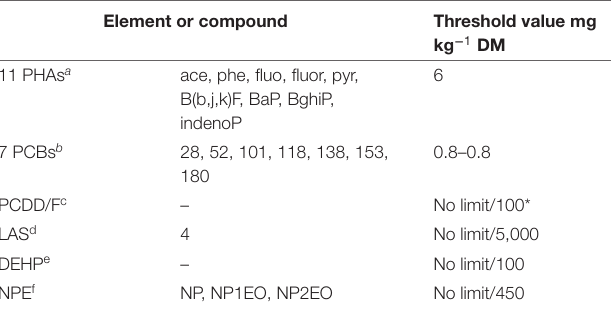
TABLE 5 | Threshold values of organic contaminants in organic wastes that may be recycled to soil for crop production [option 2-3 of the 2009 European report ( CEC,